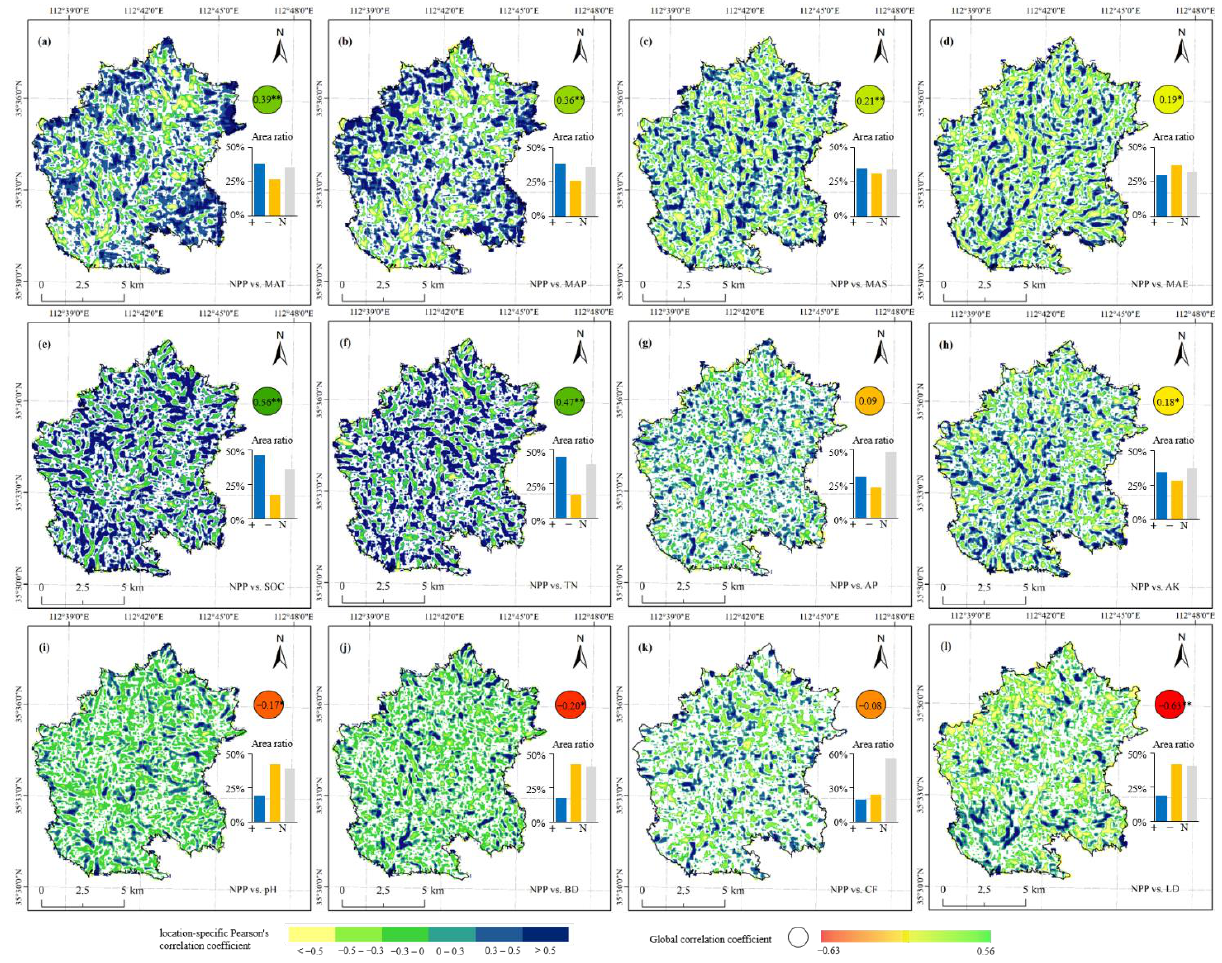
Figure 3. Spatial distributions of the location-specific Pearson’s correlation coefficient between NPP and drivers. ( a ) MAT, ( b ) MAP, ( c ) MAS, ( d ) MAE, ( e ) SOC, ( f ) TN, ( g ) AP, ( h ) AK, ( i ) pH, ( j ) BD, ( k ) CF, and ( l ) LD. All abbreviations (BD, CF, MAT, SOC, etc.) can be found in Table 1. The right inset shows the area ratios of positive, negative, and insignificant areas. ** means significant at p < 0.01 level, * means significant at p < 0.05 level.